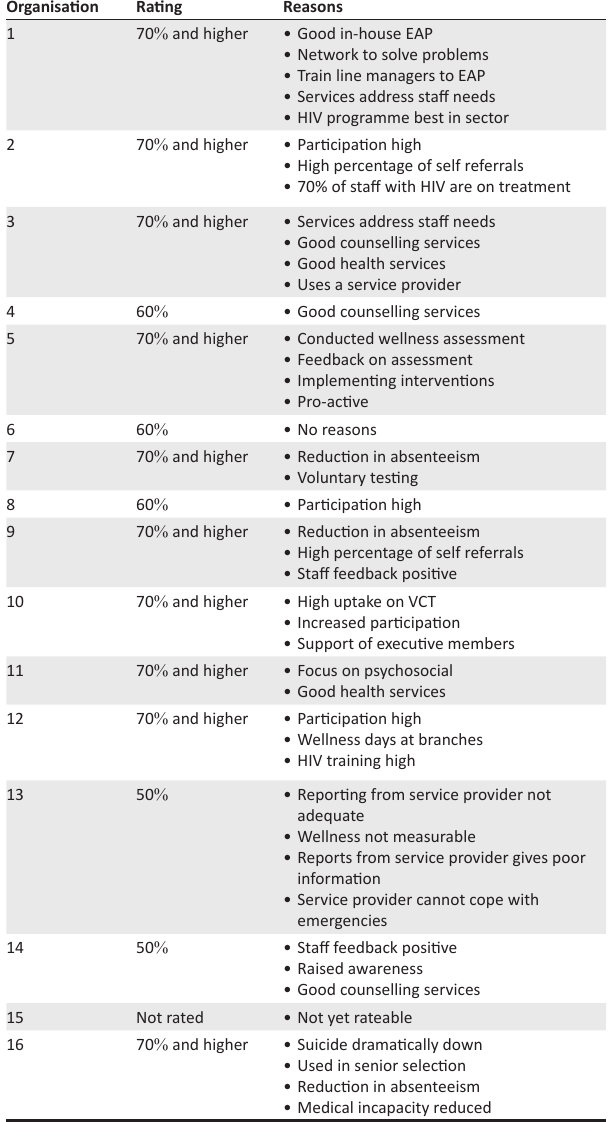
TABLE 5: Reasons why Employee Wellness Programmes were successful. Organisation